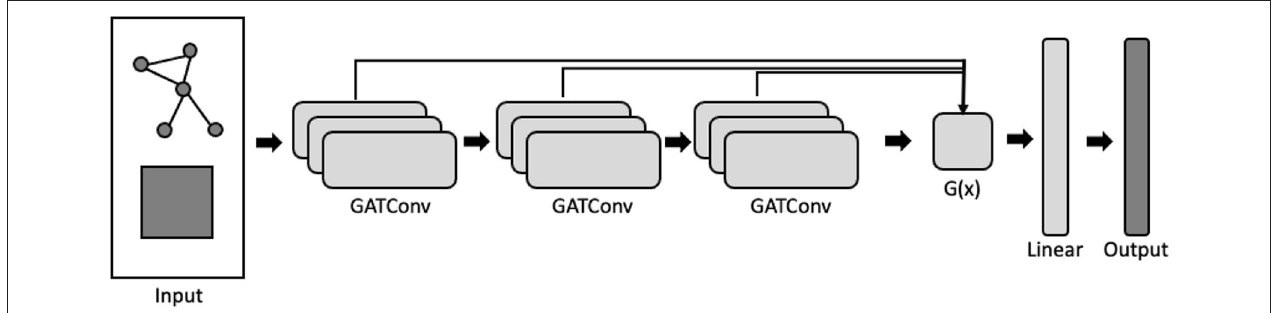
FIGURE 2 | Graph attention network employing a jumping-knowledge mechanism. The network takes as input the graph adjacency structure and the nodewise feature matrix, and outputs a node-by-label logit matrix. Each GATConv block is composed of multiple attention heads. Arrows indicate the direction of processing. Aggregation function, g ( x ), which takes as input the embeddings from each GATConv block, learns a convex combination of the layer-wise